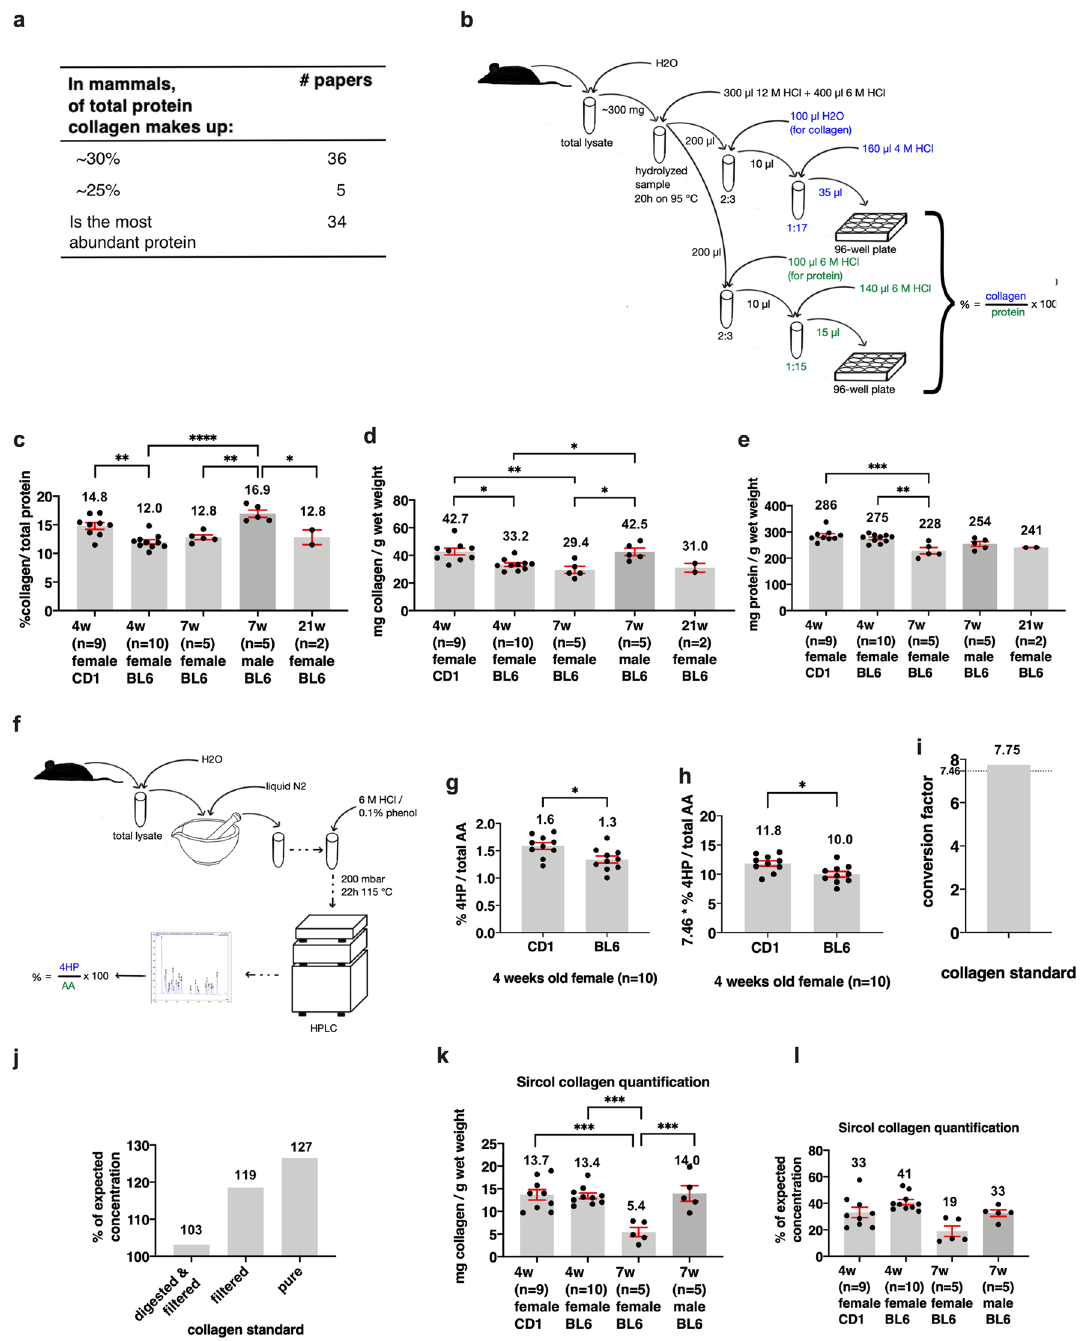
Figure 2. Collagen content of entire mice. ( a ) Literature indicating a proportion of collagen in mammalian protein. See Supplementary Table 6 for details. ( b ) Schematic representation of the total collagen and total protein assay procedure. ( c ) The percentage of collagen normalized to the total protein of a whole female mouse, calculated as shown in ( a ). The first bar depicts a CD1 mouse, whereas the others represent C57BL/6 mice. Numbers show the age in weeks (w) or sample size (n). ( d ) Illustrates the amount of collagen per gram wet weight of a mouse (mg/g). ( e ) The portion of protein per gram wet weight (mg/g). ( c – e ) see Supplementary Table 7 for details. ( f ) Illustrates the amino acid analysis procedure. Some steps are omitted (dashed lines). For detailed information, see “Materials and methods”. ( g ) shows the proportion (%) of 4HP over total amino acids (AA) of the 4 weeks old female CD1 and C57BL/6 mice. ( h ) Depicts the values shown in (f), multiplied with the 4HP to collagen conversion factor (7.46). ( g , h ) see Supplementary Table 8 for details. ( c – e , g , h ) mean ± SEM, shown is the mean of 2–10 biological replicates. Values of biological replicates were derived from 2 ( g , h ) 3 ( c – e ) technical replicates. One way ANOVA post-hoc Tukey, ** p ≤ 0.01. ( i ) Illustrates the experimentally derived conversion factor of the collagen standard. See Supplementary Table 8. ( j ) % of the expected collagen standard concentration used in the previous assays when measured with the Sircol assay (1200 µg/mL equals 100%). See Supplementary Table 10. ( k ) Illustrates the amount of collagen per gram wet weight (mg/g). See Supplementary Table 10. ( l ) The percentage of the expected collagen concentration (see d ) when measured with the Sircol collagen quantification. See Supplementary Table